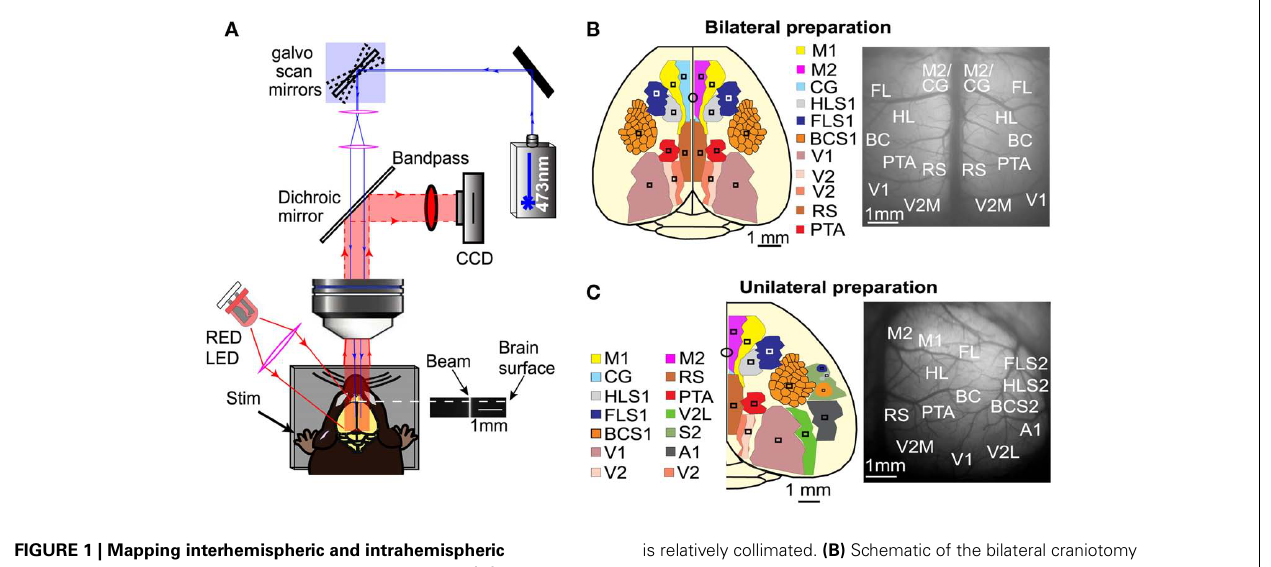
FIGURE 1 | Mapping interhemispheric and intrahemispheric connectivity using ChR2 stimulation andVSD imaging. (A) Experimental set up for simultaneous ChR2-photoactivation andVSD imaging. Galvanometer scan mirrors position a 473 nm laser at specific cortical locations whileVSD fluorescence is monitored in epi-fluorescence mode. An image of the laser beam demonstrates that it